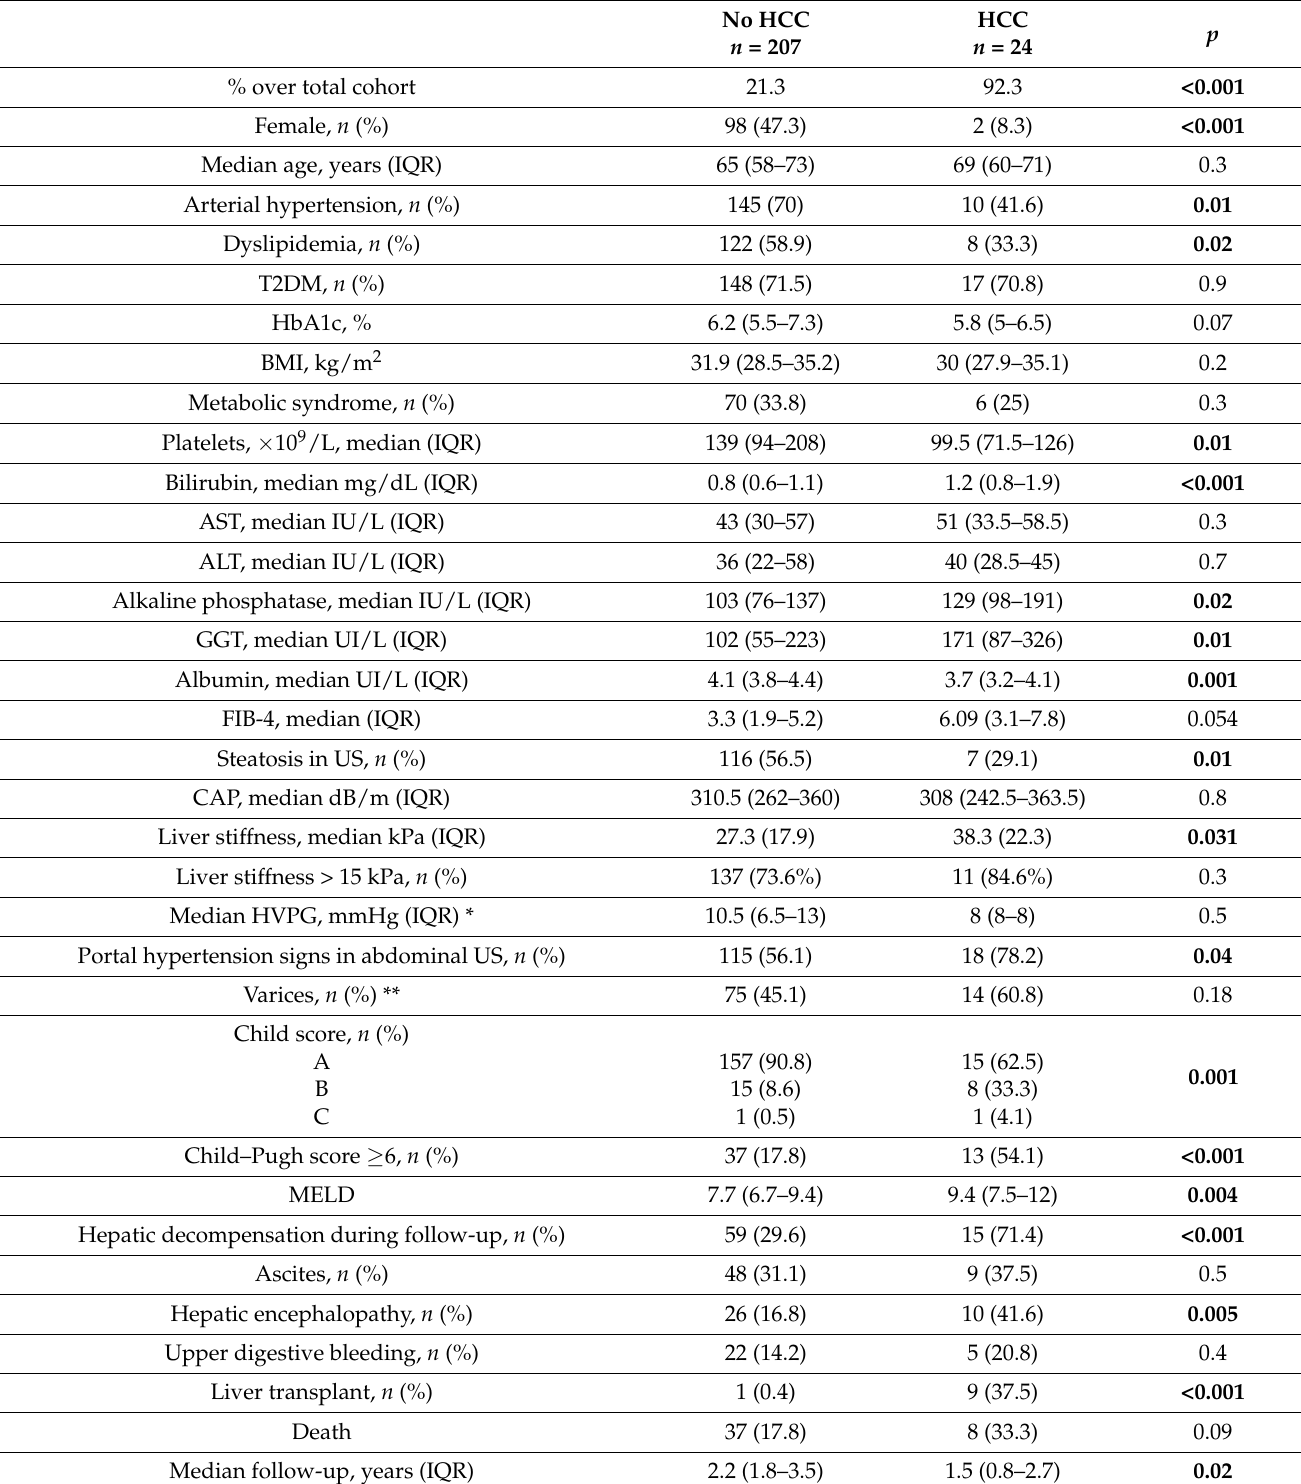
Table 2. Characteristics and outcomes of cirrhotic patients according to the diagnosis of hepatocellular